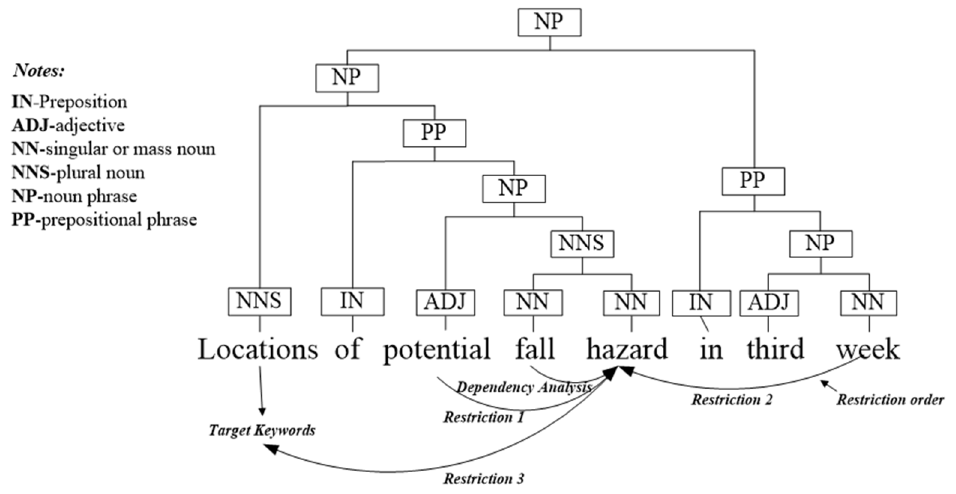
Figure 11. Syntactic structure